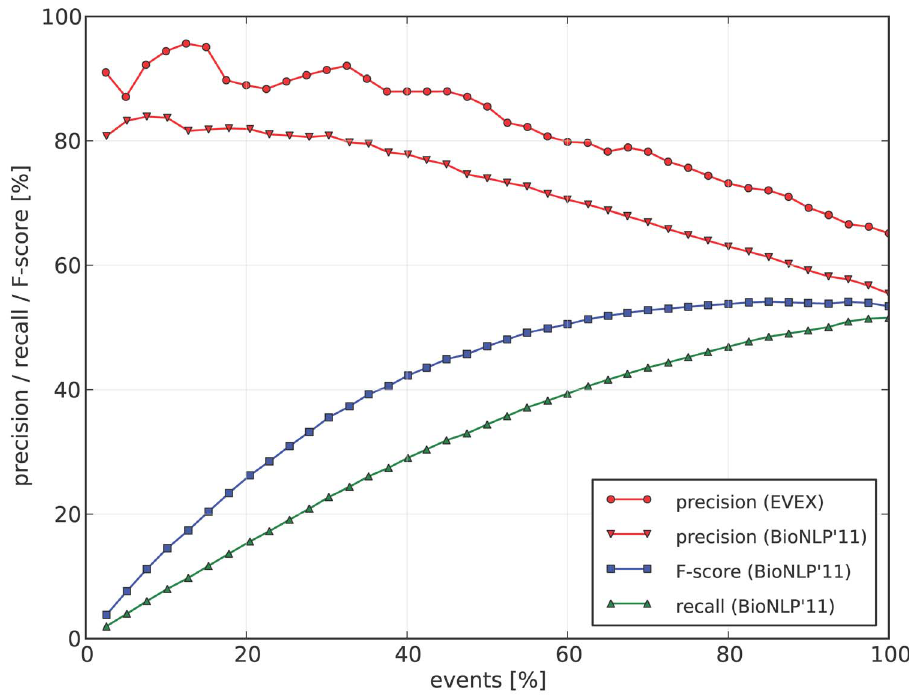
Figure 4. Event extraction performance. Both the evaluations of the BioNLP ST’11 GE task development set (3021 events, ST evaluation scripts) as well as a fully random sample (200 events, manually evaluated) are depicted. Events are ordered by their confidence scores, and plotted at